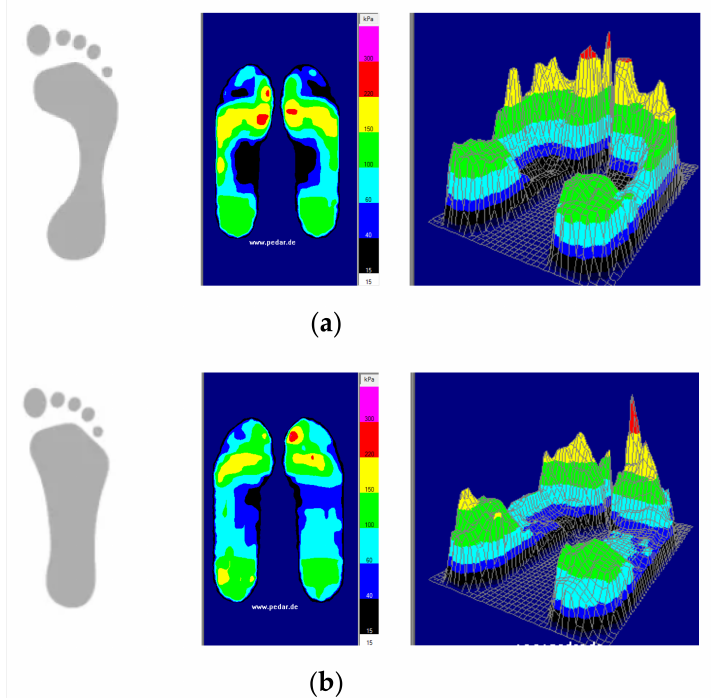
Figure 2. Plantar pressure distribution of athletes: ( a ) regular pattern; ( b ) flat